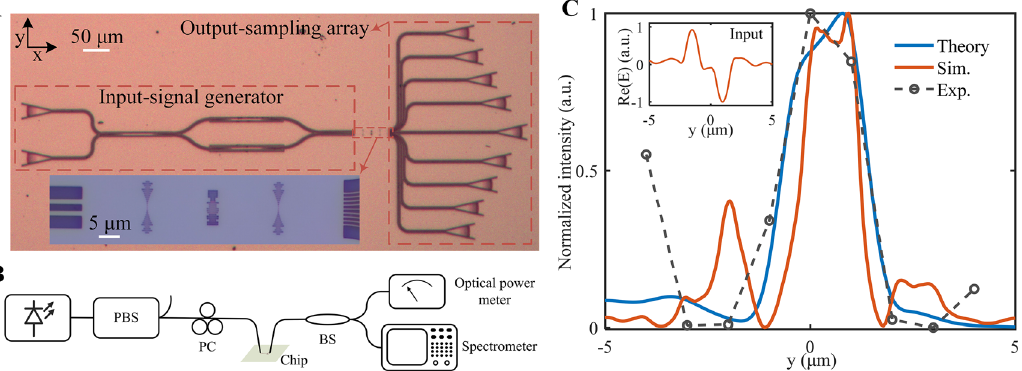
Figure 3: Experiments and results. (A) Optical microscope images of fabricated schemes of fabricated on-chip integrator cascaded with input-waveguides and output-sampling array. (B) Experimental setup. (C) Comparison of simulated, experimental and theoretical